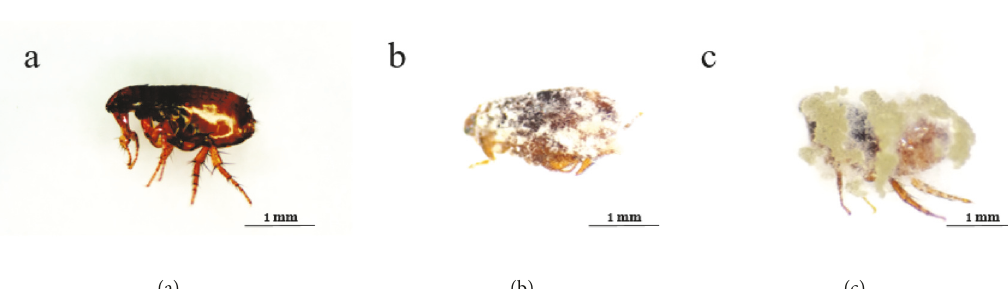
Figure 1: Cumulative mortalities of Ctenocephalides sp. male and female adults after exposure to fungal aerial conidia. (a) Healthy adult of Ctenocephalides sp., (b)adults of Ctenocephalides sp. (72h) afterdeath caused by B. bassiana isolateBCMU4, and (c) Adults of Ctenocephalides sp. (72 h) after death caused by M. anisopliae All the scales bars are 1